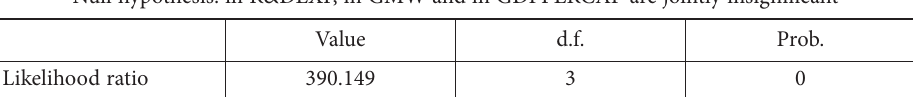
Table 6. Summary of the Redundant Variables Likelihood Ratio test